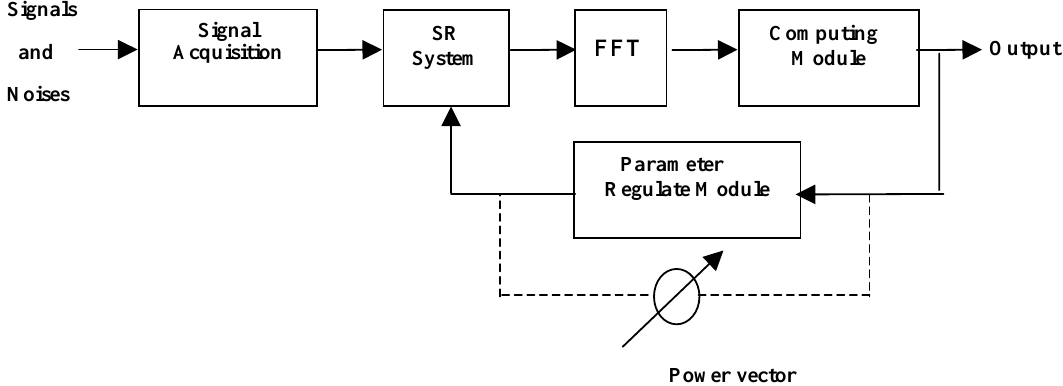
Figure 3. Scheme of signal detecting with SR